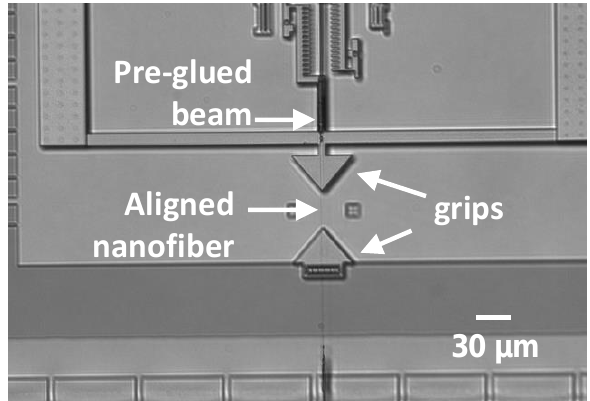
Figure 6. Optical image showing the pre-glued beam and an aligned nanofiber.